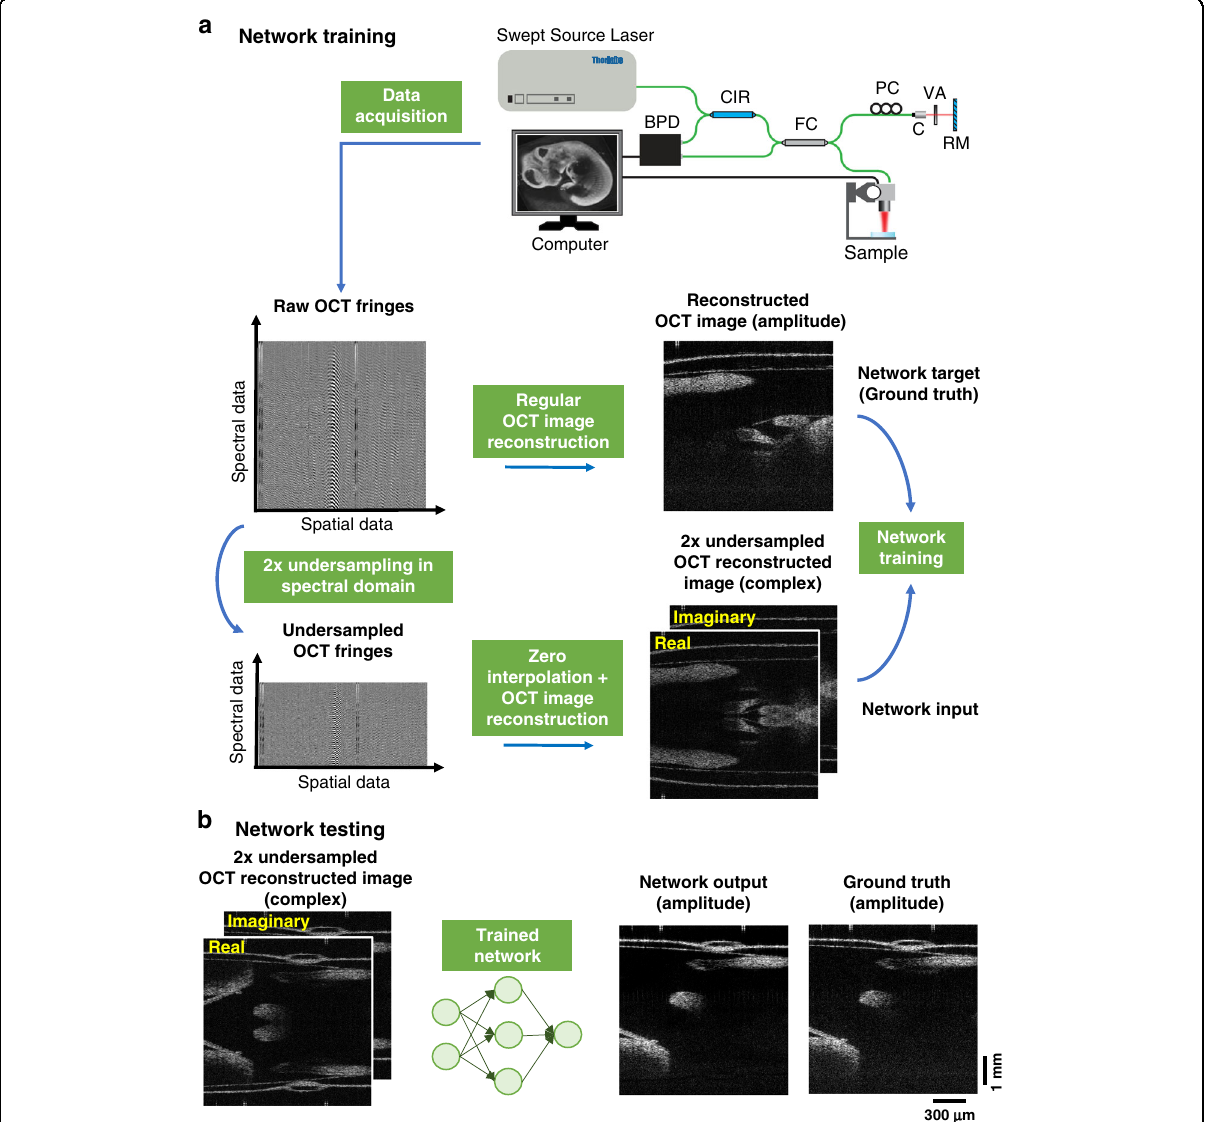
Fig. 1 Schematic of the DL-OCT image reconstruction framework. a Training phase of DL-OCT. Raw OCT fringes were captured by an SS-OCT system. The network target (ground truth) was generated by direct reconstruction of the original OCT fringes as detailed in the “ Materials and methods ” section. The network input was generated by a 2-fold down-sampling of the spectral data for each A-line, zero interpolation, and reconstruction of the resulting fringes. b Testing phase of the DL-OCT. We passed the 2× undersampled OCT image (real and imaginary parts) through a trained network model to create an aliasing-free OCT image, matching the ground-truth reconstruction that used all the spectral data points (see “ Materials and methods ” section for